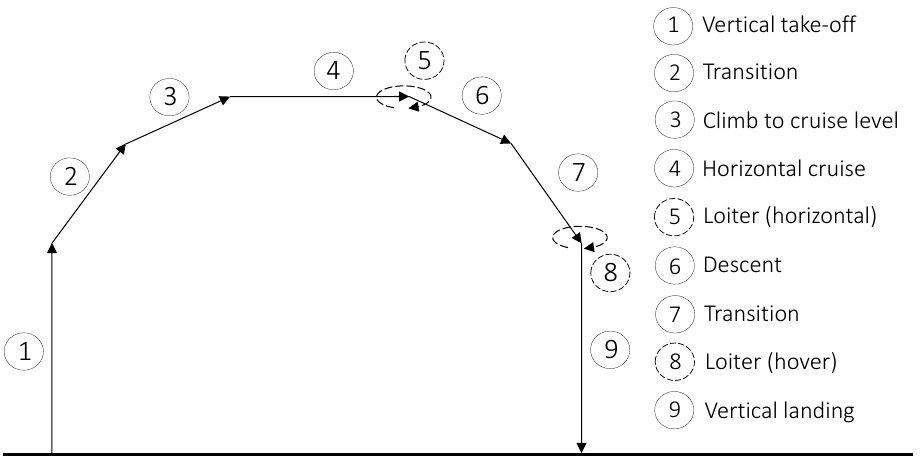
Figure 3. Schematic of the 9 flight phases of a regular eVTOL flight